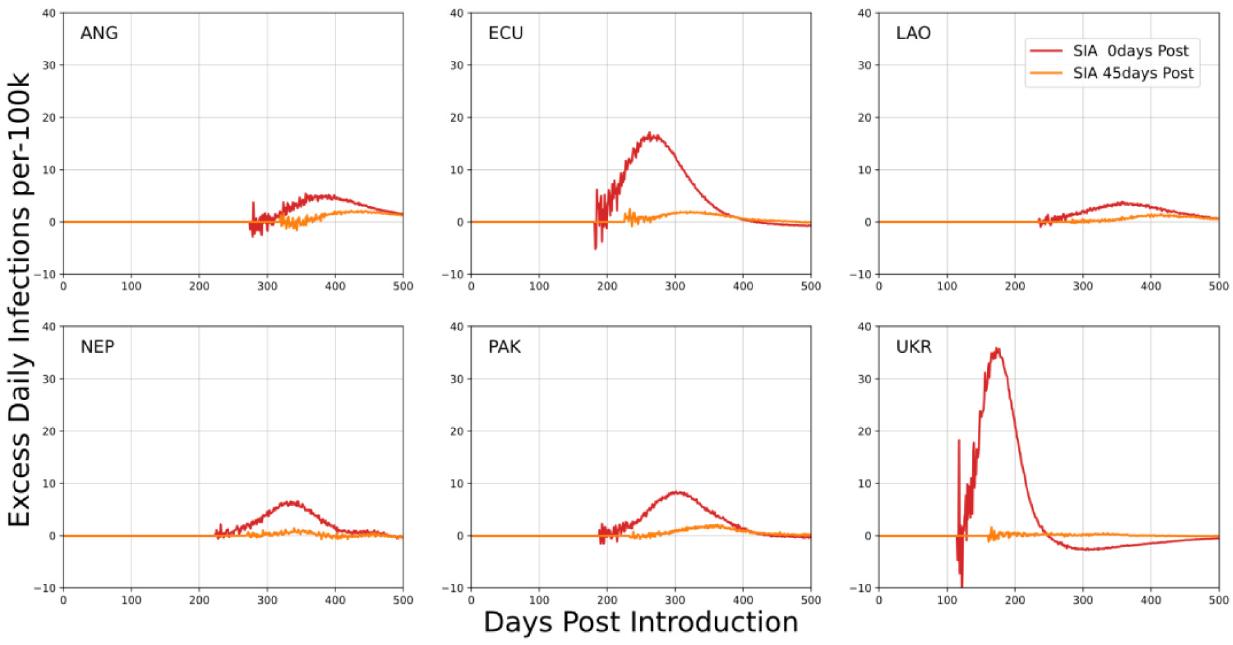
Figure 4. Mean excess daily SARS-CoV-2 infections per 100k individuals in each country examining house-to-house SIAs in mixed urban-rural simulations. Scheduling of SIAs is with respect to the time of peak incidence. The x-axis describes the number of days post SARS-CoV-2 introduction to the community.